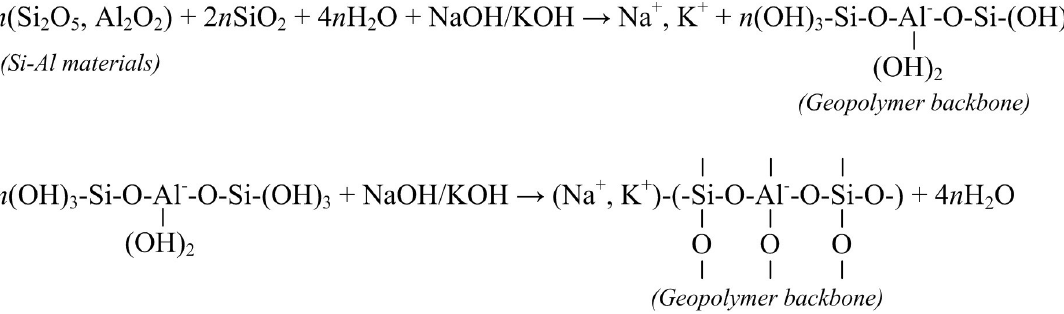
Figure 5. Schematic diagram of reaction steps involved during geopolymer formation. Table 2. Average SiO